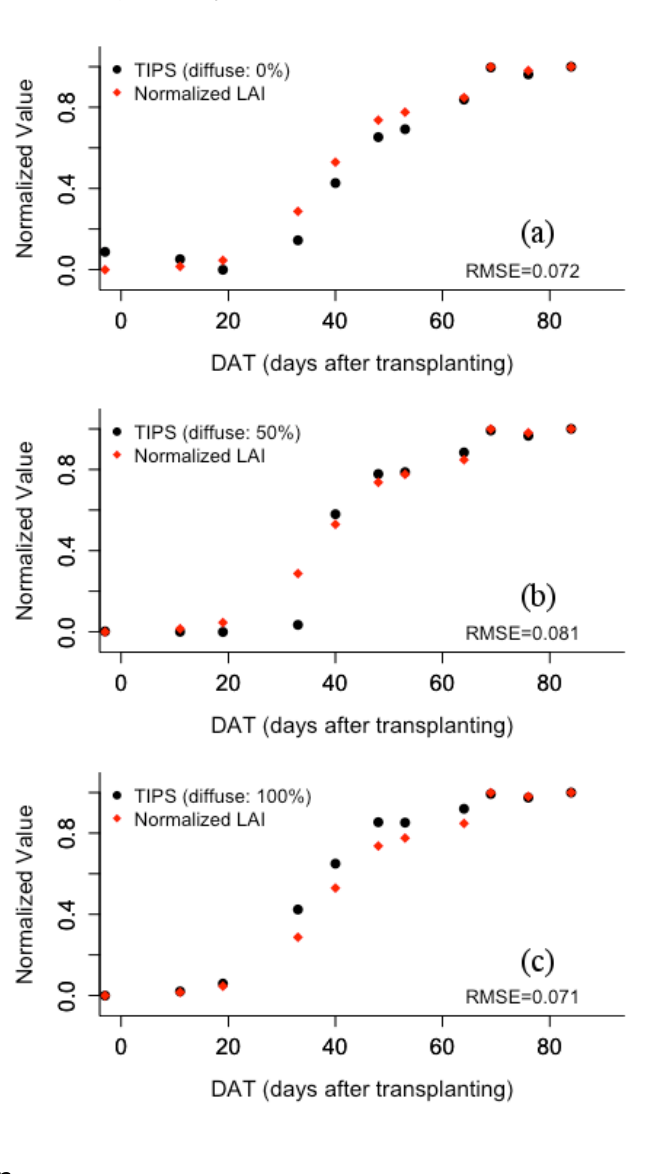
Figure 1. Simulation results of TIPS behavior with increasing values of LAI on a paddy field, as derived from FLiES. The panels show the results with diffuse radiations of ( a ) 0%, ( b ) 50%, and ( c ) 100%,